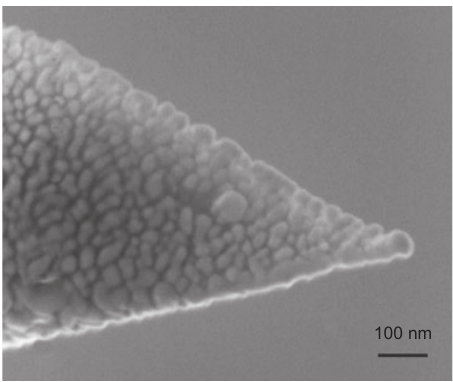
Figure 11 Near-fi eld probe coated with a thin silver fi lm forming a 30-nm near-spherical silver bead at the tip. Reprinted with permis- sion from [97] . Copyright 2009, EDP Sciences.